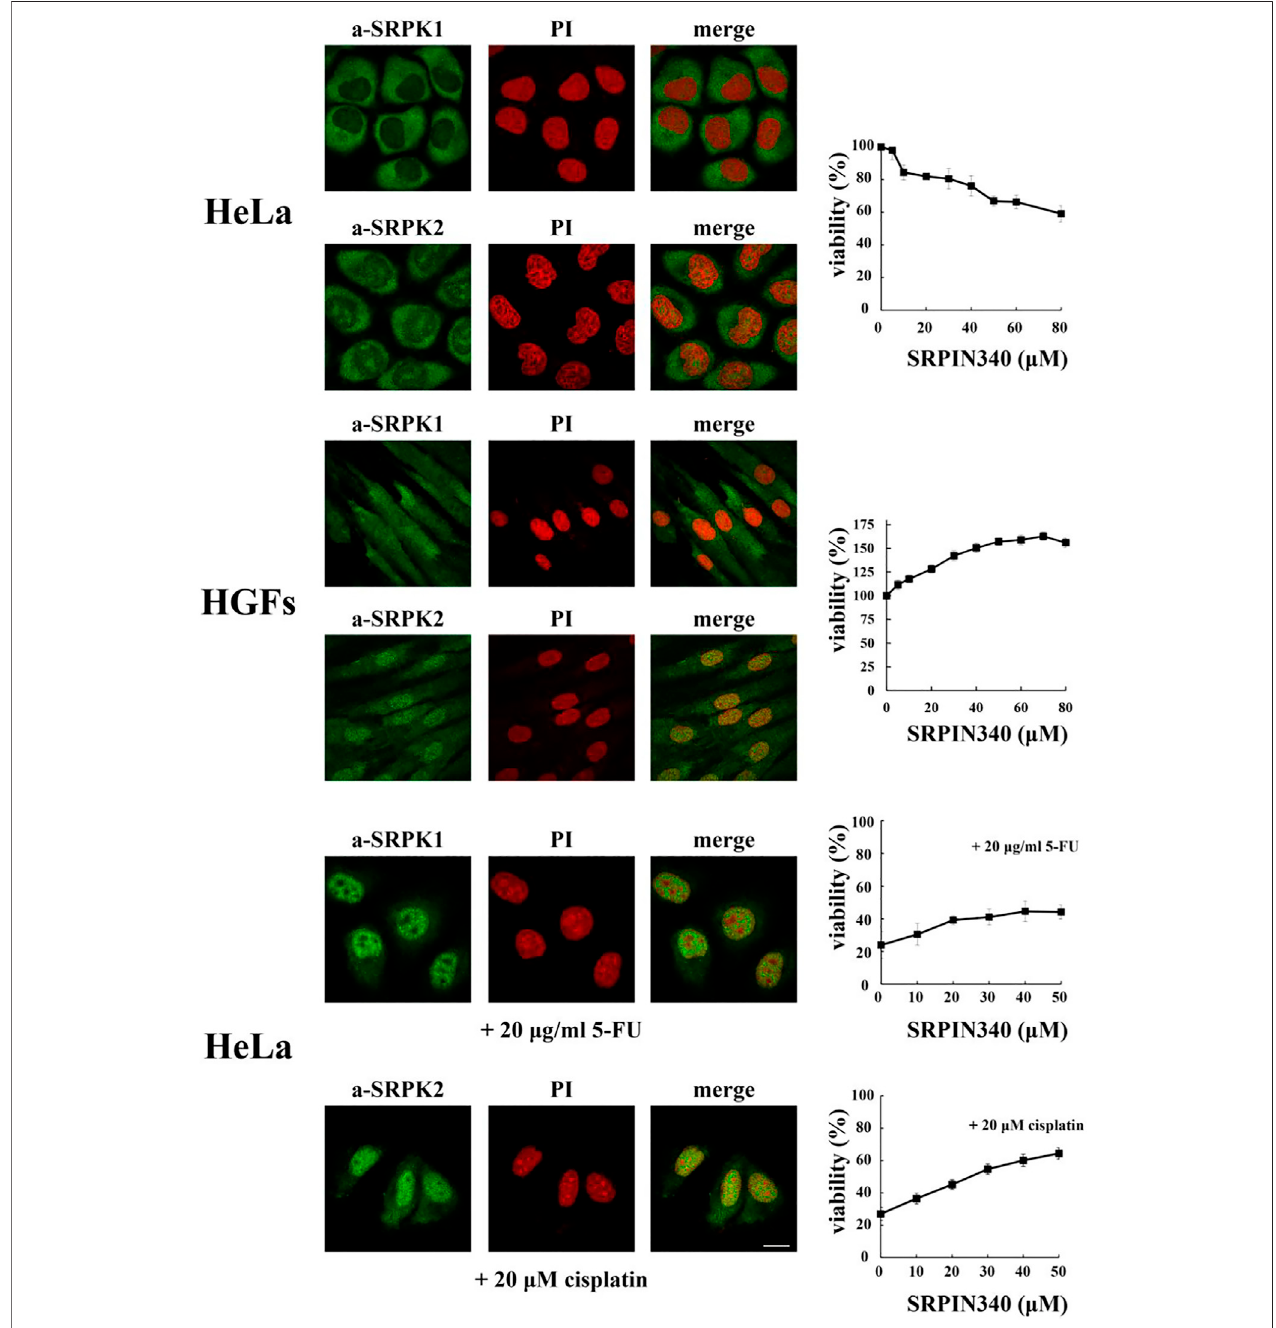
FIGURE 3| Fluorescent patterns ofSRPK1 and SRPK2 in HeLacells, human gingival fi broblasts(HGFs), HeLa cells treated with 20 μ g/ml 5-FU for 48 h and HeLa cellstreatedwith20 µMcisplatinfor24 h(leftpanels).SRPK1andSRPK2weredetectedusingtherespectiveanti-SRPK1andanti-SRPK2monoclonalantibodies,while the nuclei were stained with PI. Scale bar: 10 µm. In each case the effect of kinase inhibition, by SRPIN340, on the number of viable cells was measured using an MTT assay (right panels). Viability is expressed as a percentage of the viability of untreated cells, which was set to 100 percent. The data on HeLa cells were taken from Sigala et al. (2021a) and Sigala et al.